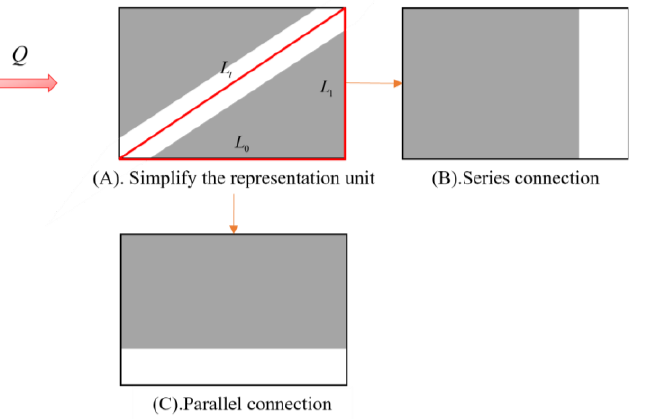
Figure 2. Geometric analysis; ( A ) A geometric reduction of the representation unit( B ) series connec- tion; ( C ) parallel connection.